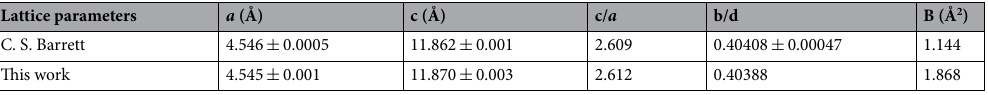
Table 1. Summary of room temperature lattice parameters of our Bi nanofilm. Bulk single crystal results 20 are listed for